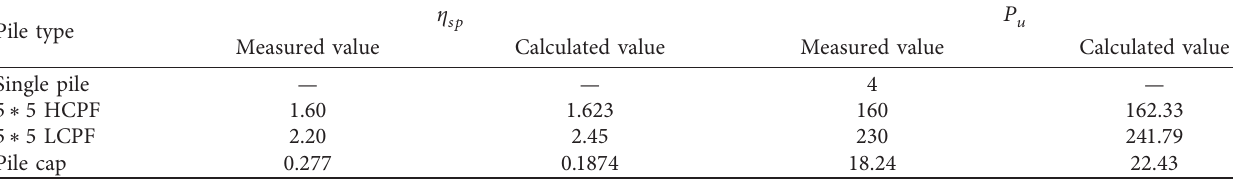
Table 4: Calculated and measured